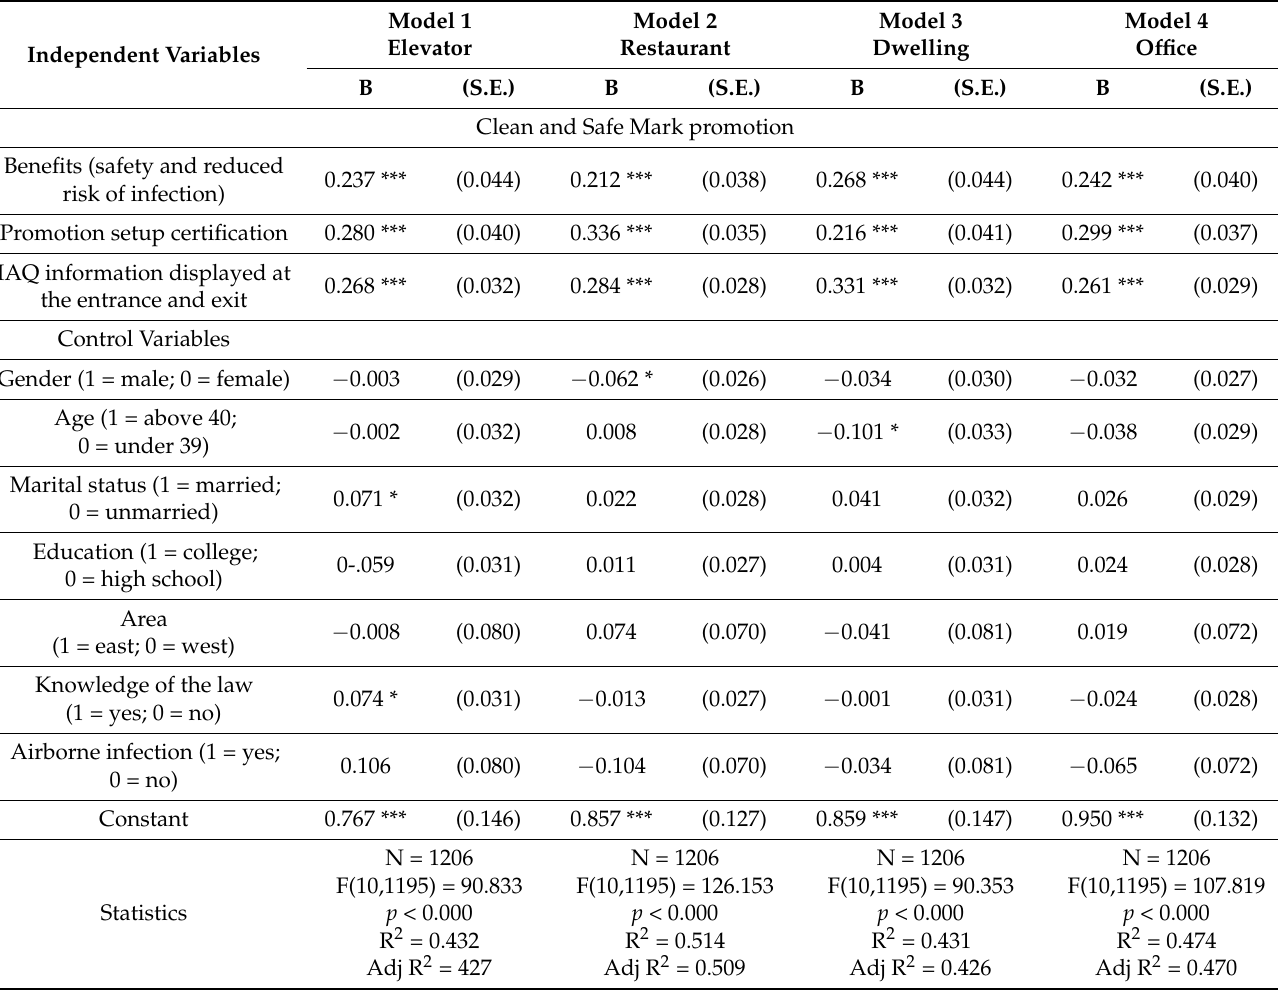
Table 10. The “Clean and Safe” mark promotion regression (four cases).